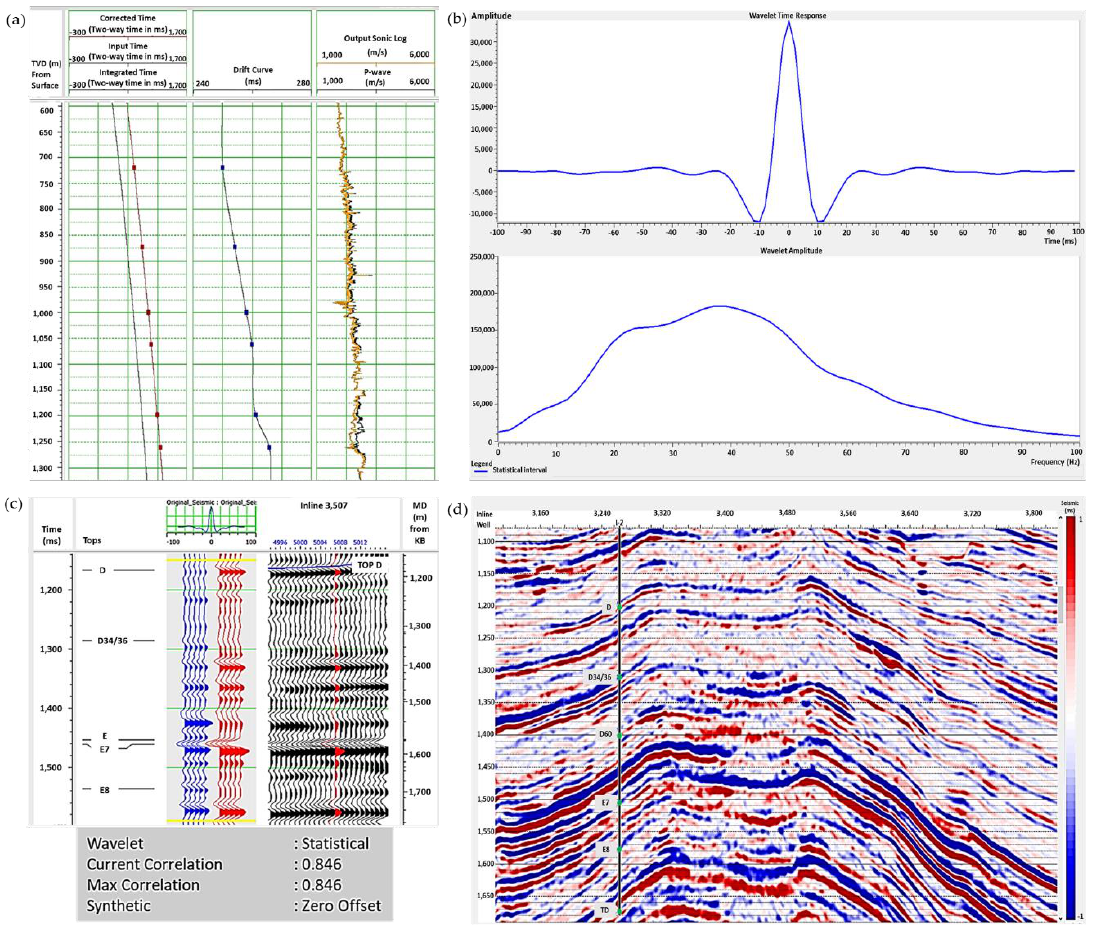
Figure 4. Well log seismic tie for I-2 log, ( a ) check shot correction in one of the logs, ( b ) statistical wavelet with timely response and respective amplitude spectrum on the bottom, ( c ) an example of a well seismic tie in the research area. The blue seismic traces were the calculated synthetic, and the red seismic traces were the real seismic data using statistical wavelet, and ( d ) seismic section which was tied with well log.